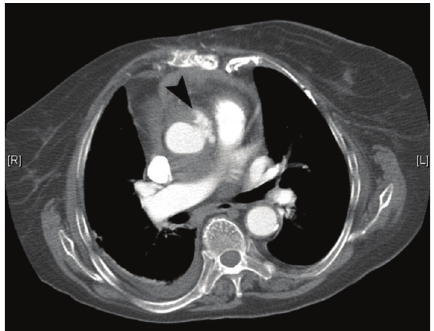
Figure 1: Axial slice from contrast-enhanced CT study depicting sternalosteomyelitisandalargerelatedmediastinalcollection(black curved arrow). The collection has higher density than that of water in keeping with pus and/or a degree of haemorrhage.